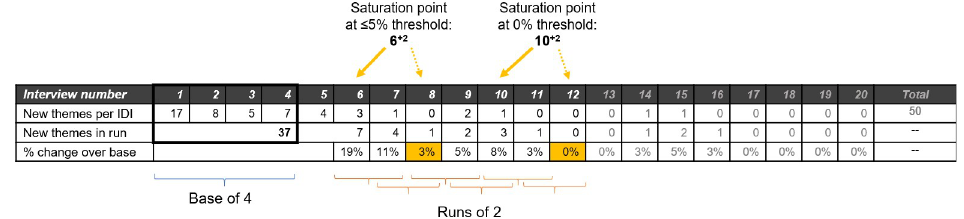
Fig 3. Hypothetical data for example of saturation assessment at base size 4 and run length